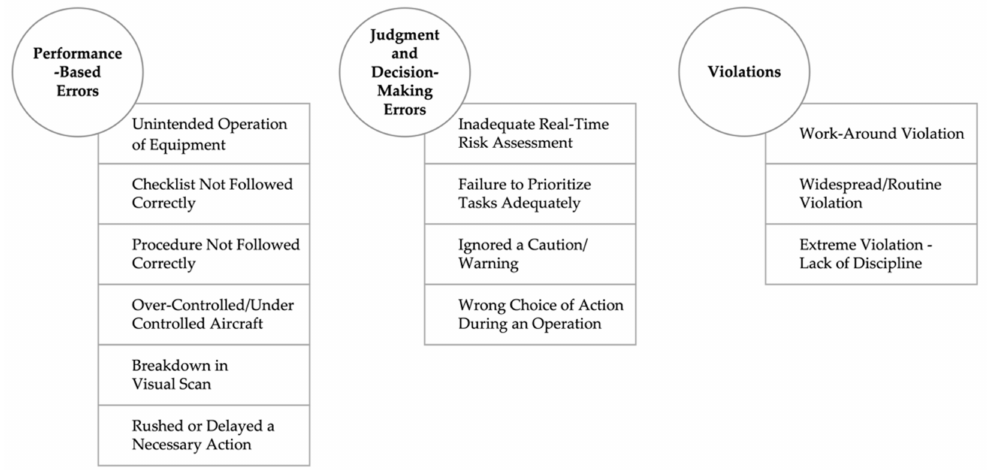
Figure 1. Subordinate categories of pilots’ unsafe acts according to DoD-HFACS